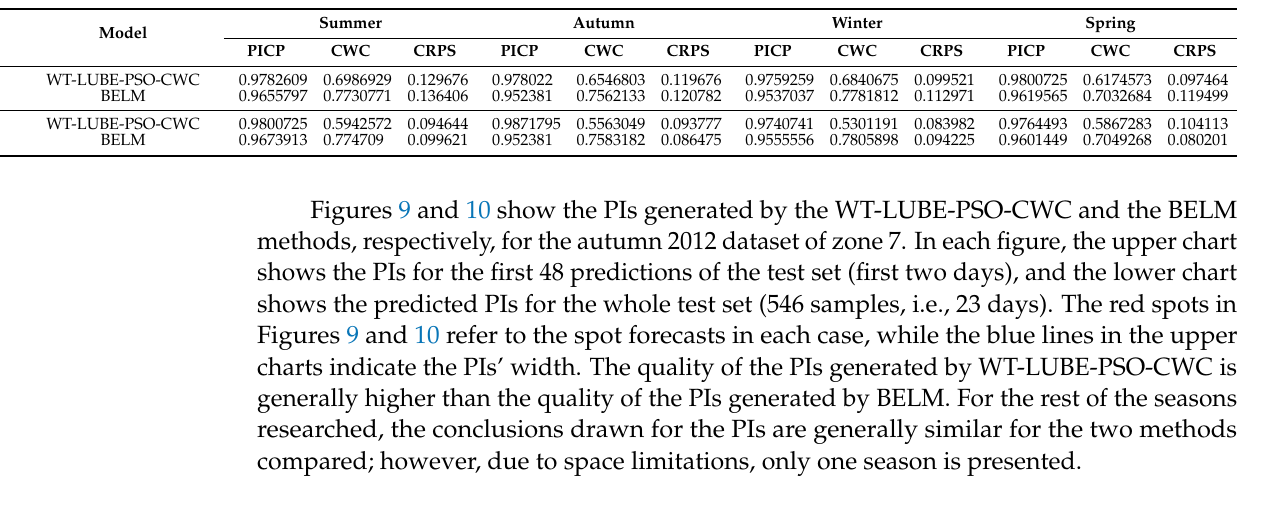
Table 12. Results of the evaluation of WT-LUBE-PSO-CWC and BELM models in zone 1 and zone 7 for summer 2012 to spring 2013 at the 0.95 confidence